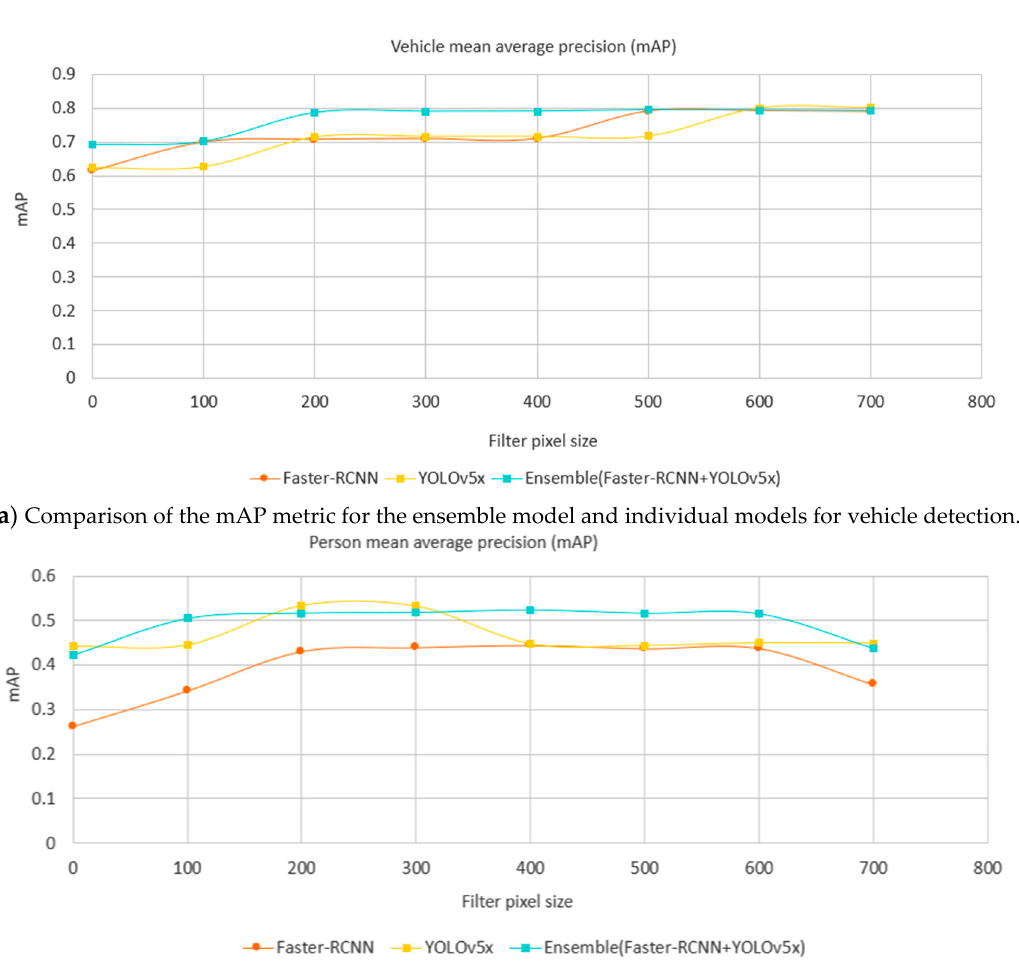
( b ) Comparison of the mAP metric for the ensemble model and individual models for person detection. Figure 14. Comparison of the mAP metric for the ensemble model, and components of Faster-RCNN and YOLOv5x models by minimum label size in pixels (horizontal axis) and label class (chart; above vehicles, below people) showing the superior performance of the ensemble method over its constituents.